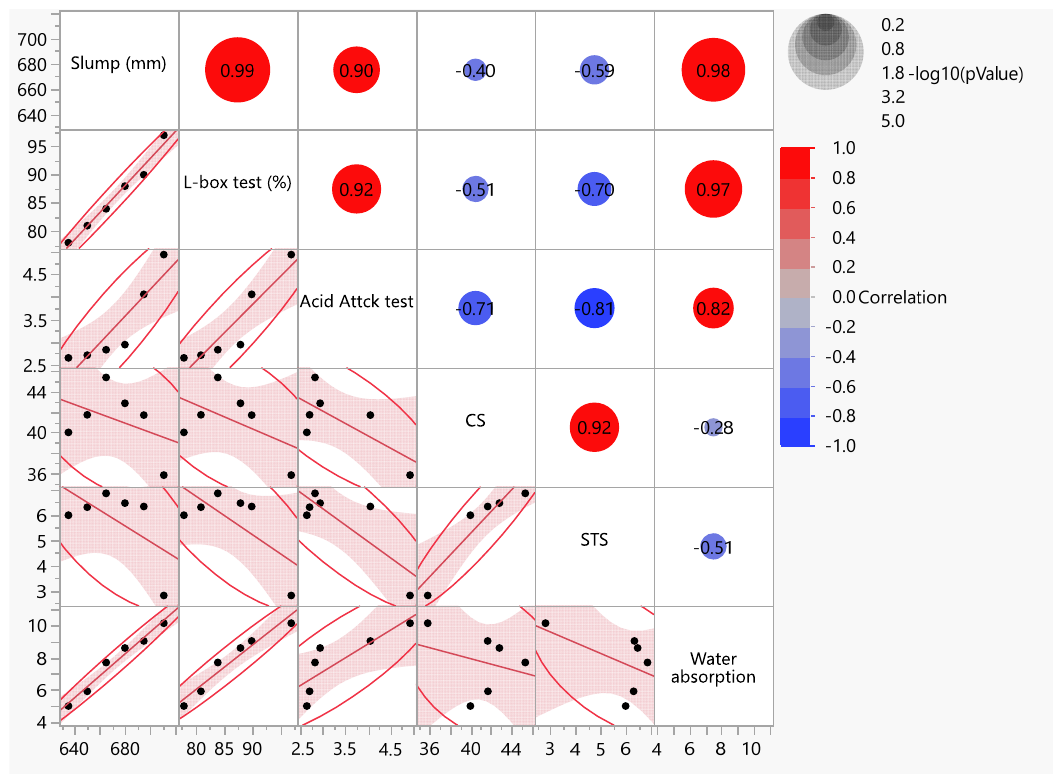
Figure 21. Correlation analysis of fresh and hardened concrete properties. Table 12. Multiobjective Optimization.